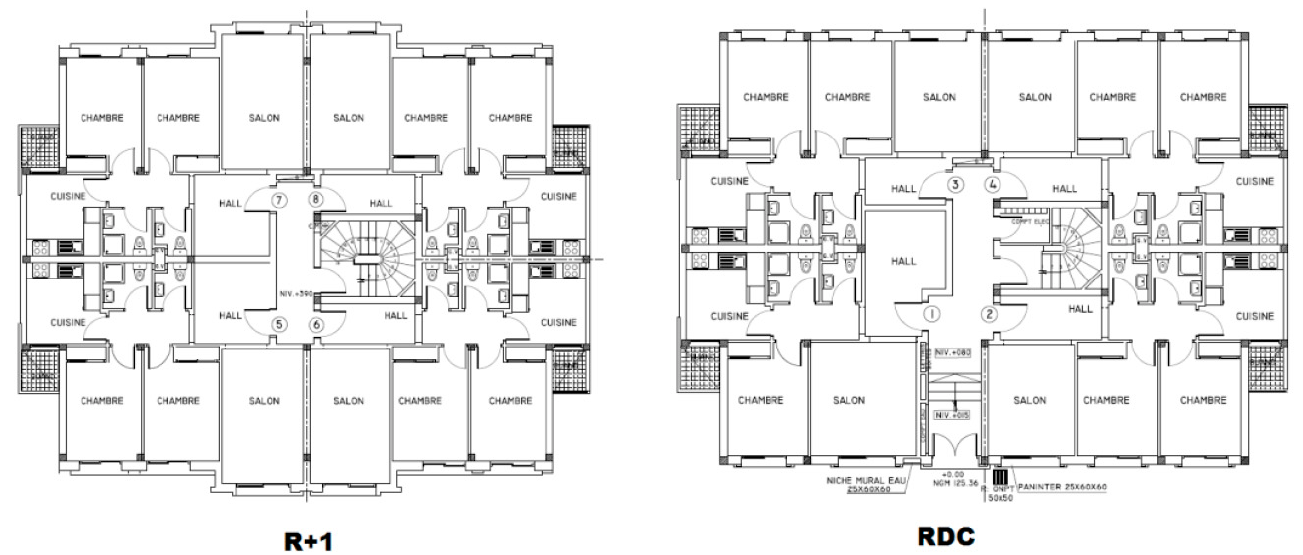
Figure 2. The architectural plan of the ground floor and a representative floor.